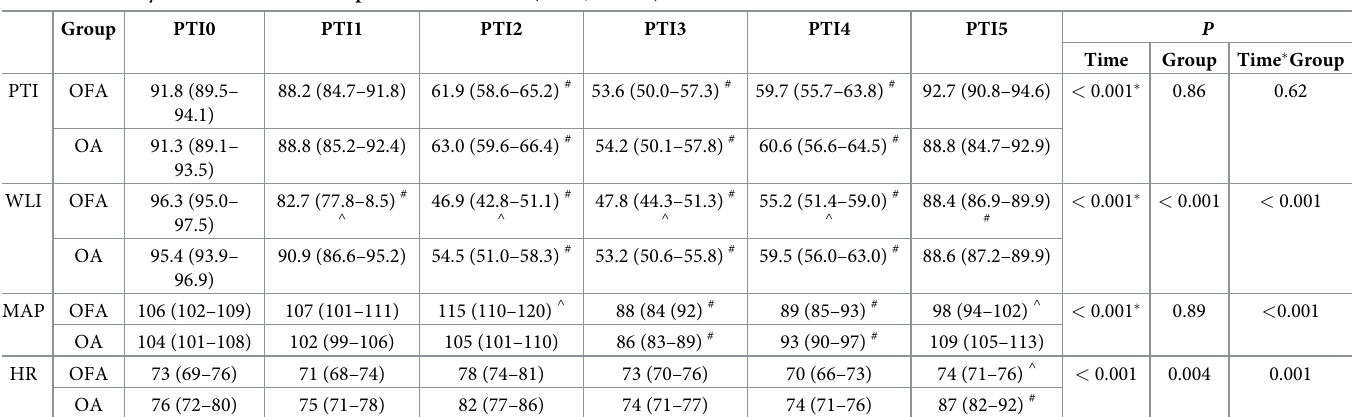
Table 3. Summary of PTI and WLI with repeated measurement (mean, 95% CI).